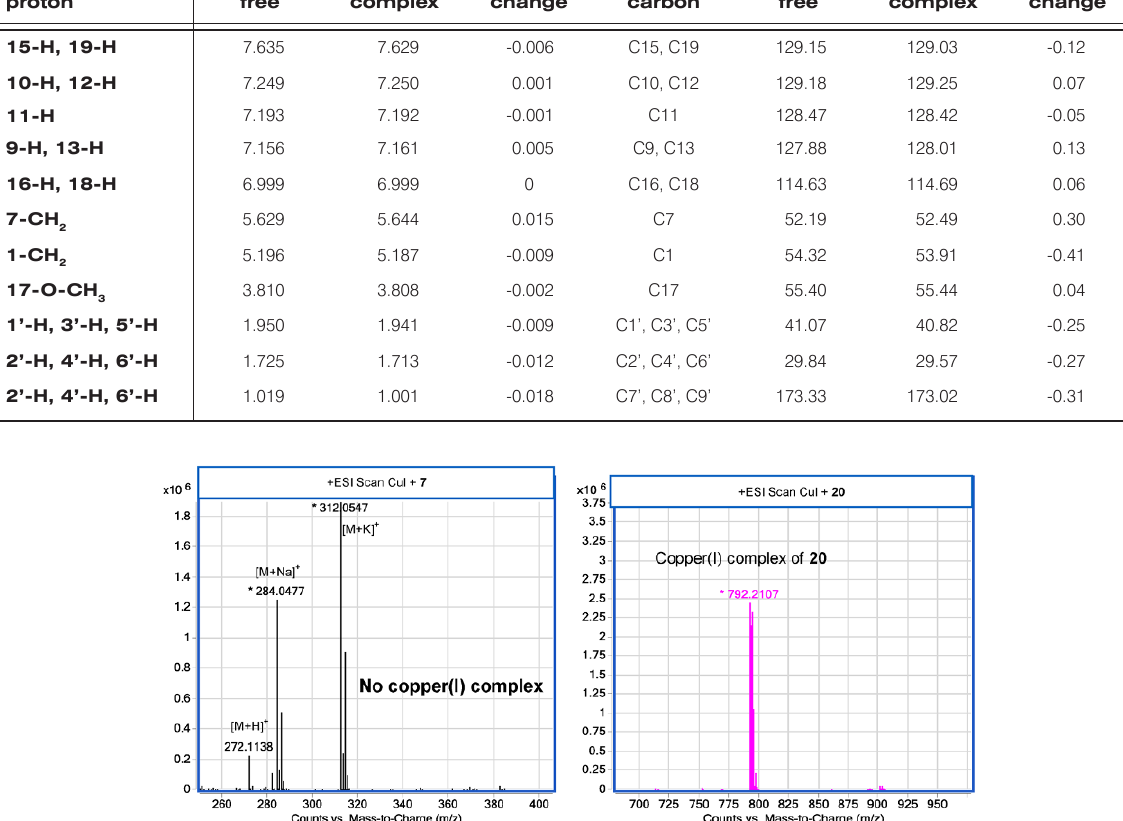
Table 4. Proton and carbon chemical shifts of free and Cu(I) complexed 24 in ACN- d proton free